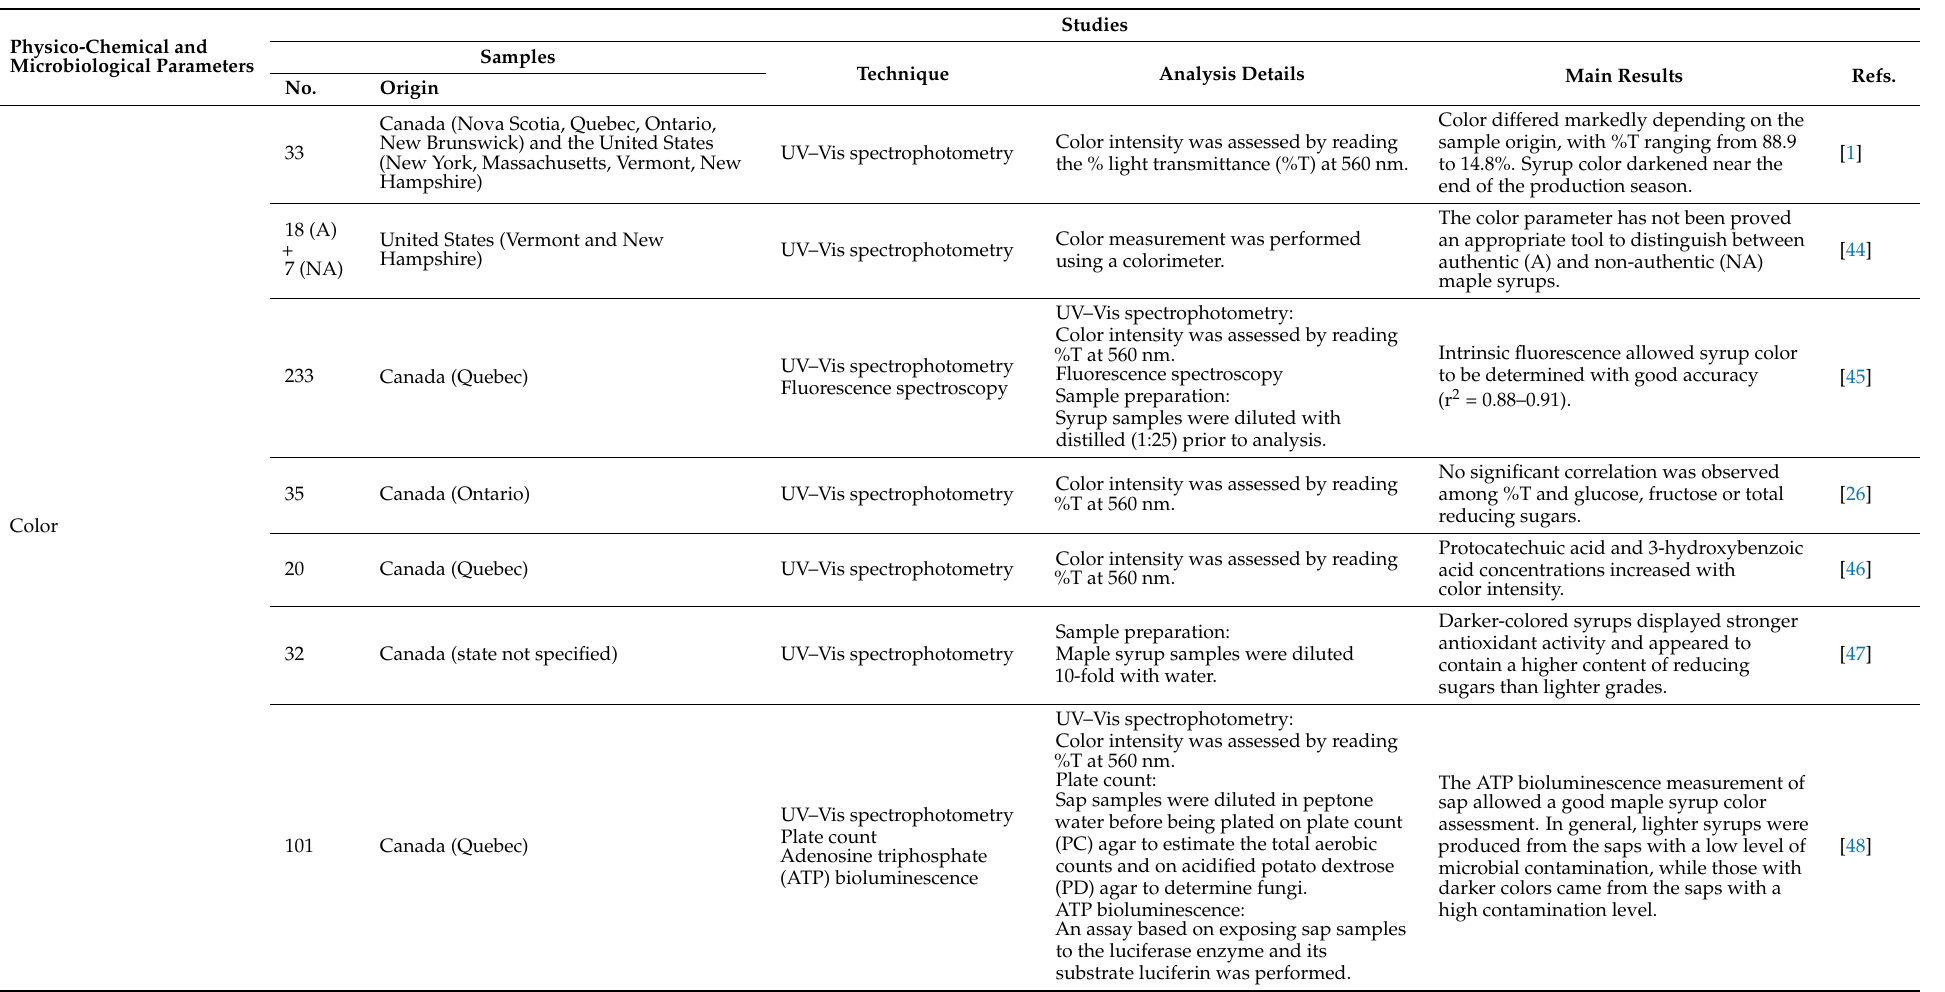
Table 1. Physico-chemical and microbiological analyses of maple